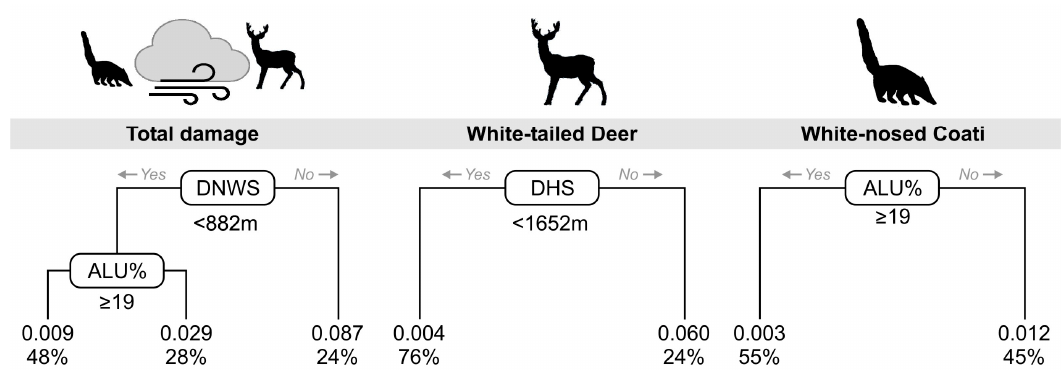
Figure 2. CARTs (classification and regression trees) representing the variation in damage to maize cobs by all factors and only by white-tailed deer or white-nosed coati, separately. in the REBIOSH in relation to landscape features considered. DNWS = distance to nearest water source; %ALU = % of agricultural land use in the surrounding 113 ha landscape unit; DHS = distance to nearest human